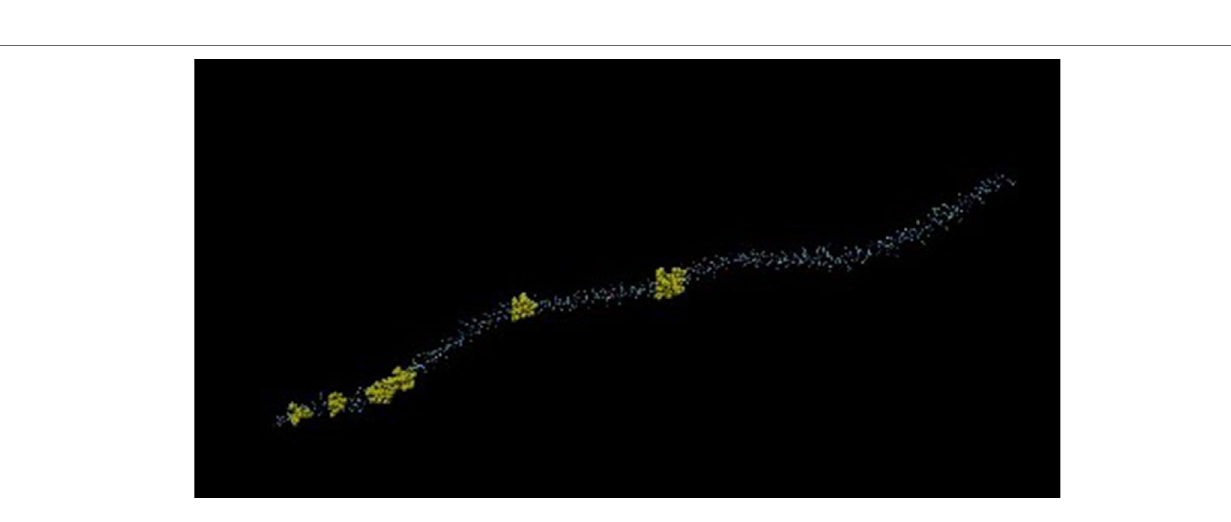
FigUre 9 | Three-dimensional structure of tropomyosin. Yellow area showing the mimicking epitopes.